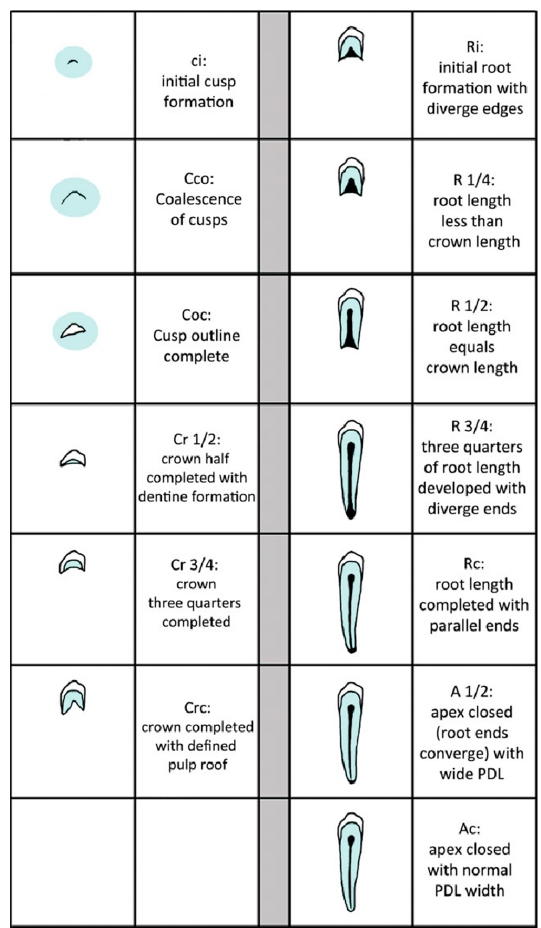
Figure 2. The stages of tooth formation for assessing the development of single-rooted teeth. Taken from S.J. AlQahtani, M.P. Hector, and H.M. Liversidge. The London Atlas of Human Tooth Development and Eruption. Am J physical anthropology 2010, 142(3):481–490.